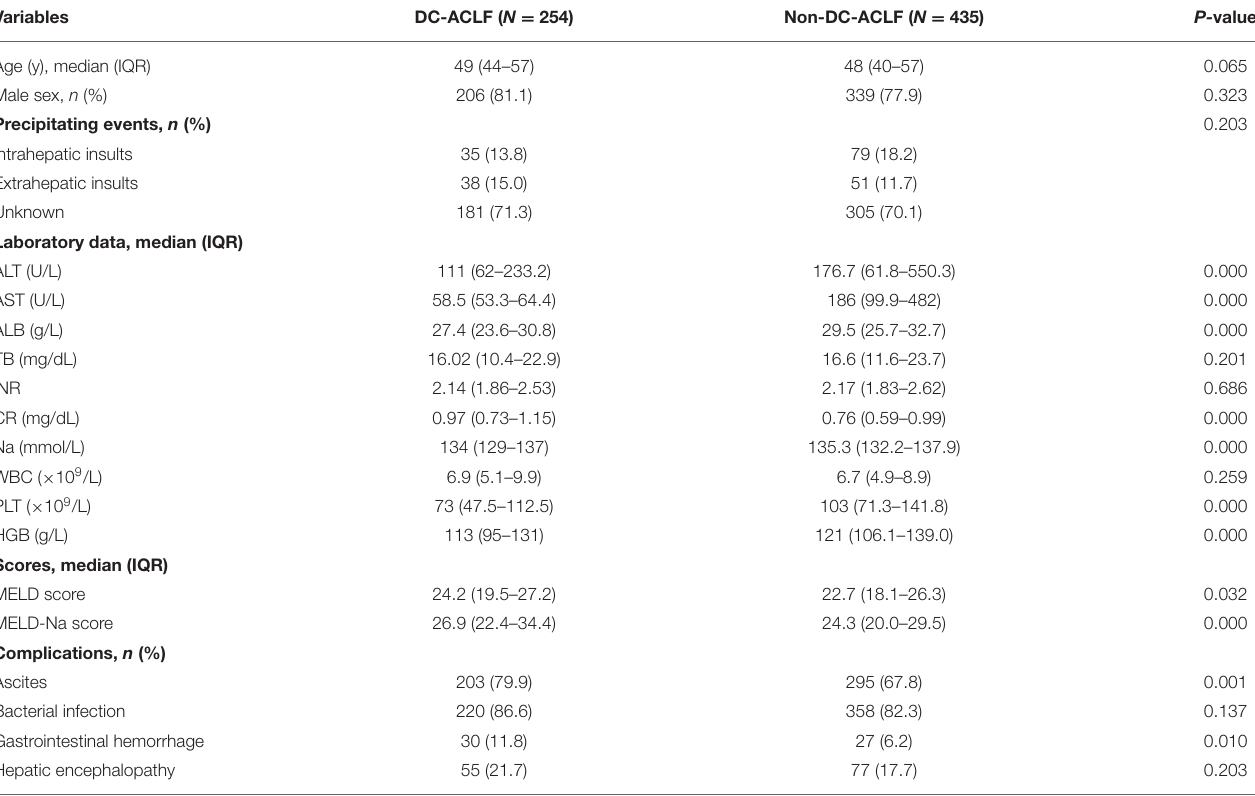
TABLE 2 | Characteristics of acute-on-chronic liver failure (ACLF) patients with and without decompensated cirrhosis (DC).